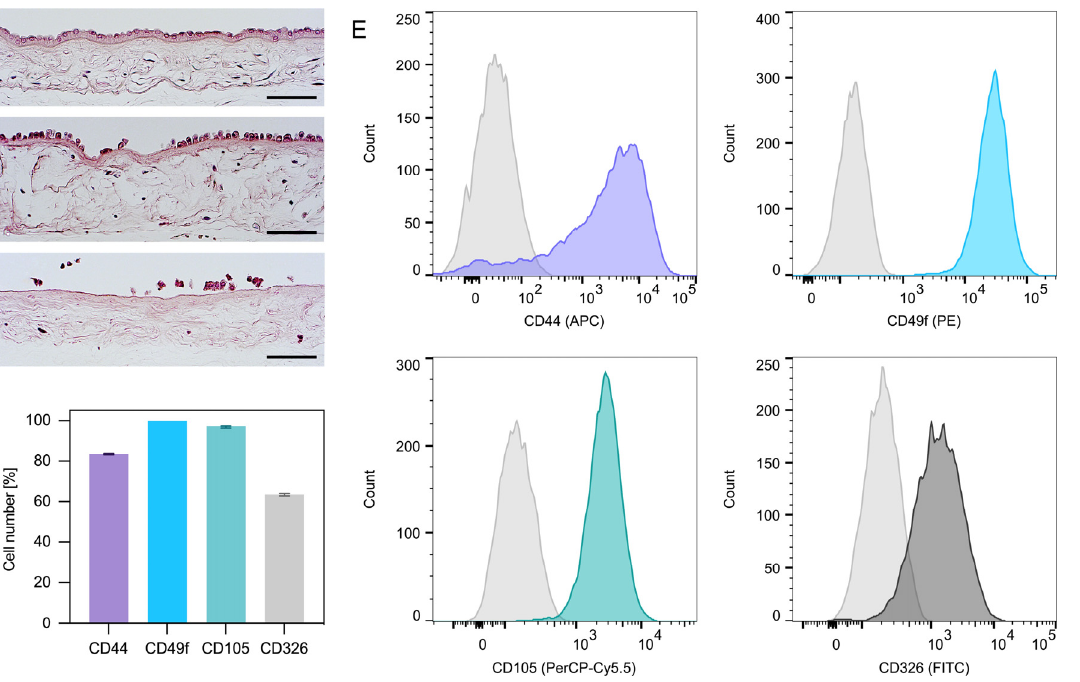
Figure 1. Amnion staining and expression profile of hAECs. Amnion before digestion ( A ) and after the first ( B ) and second digestion ( C ). The hAECs were attached to a collagen membrane forming a monolayer of columnar/cuboidal cells (hematoxylin and eosin; scale bars: 100 µm). Expression profile of hAECs determined by flow cytometry analysis ( D ). The hAECs in culture expressed both mesenchymal markers (CD44 and CD105) as well as epithelial markers (CD49f and CD326) ( D , E ).